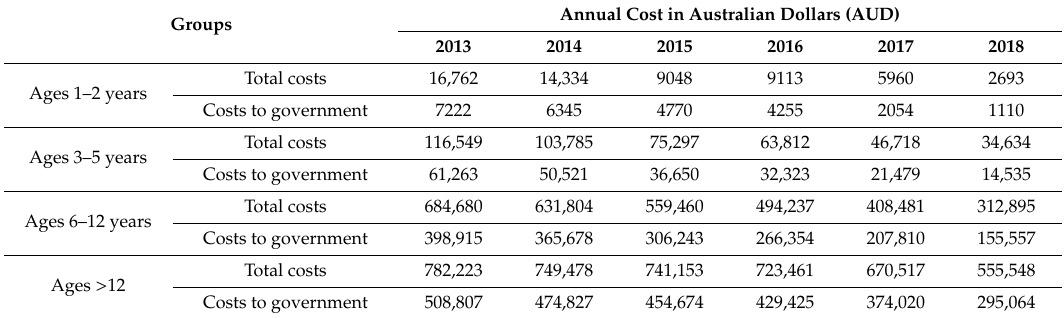
Table 2. Costs of fixed dose combination medicines by year in 10% PBS sample; 2013–2018,